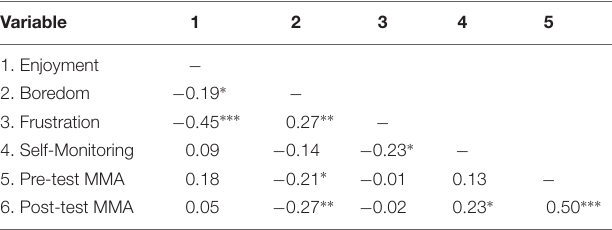
TABLE 6 | Pearson correlations between aggregated learner-state variables and pre- and post-test MMA. Variable 1 2 3 4 5